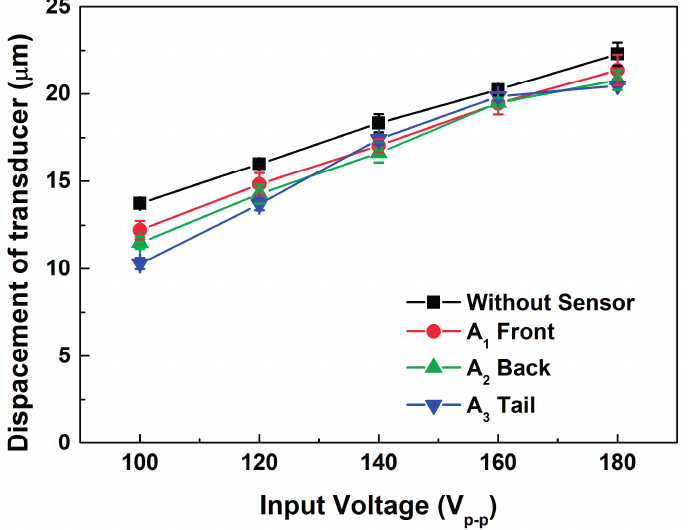
Figure 7. Longitudinal displacements with different sensor